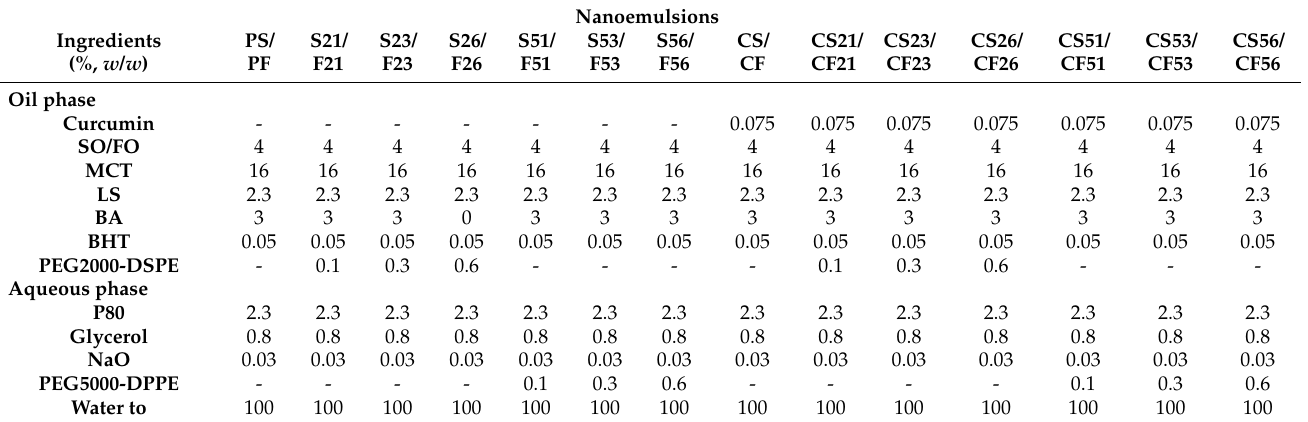
Table 1. Composition of placebo and curcumin-loaded